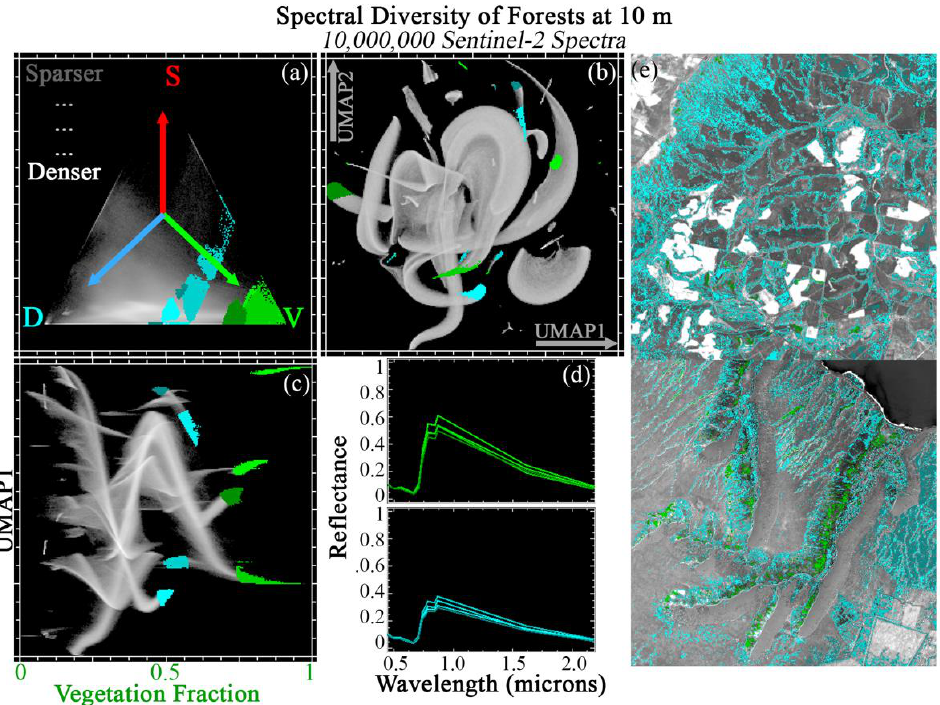
Figure 9. Joint characterization of forests (2). 10 × 1 megapixel Sentinel-2 tile subsets are selected from global forest diversity hotpots and analyzed at full 10 m pixel resolution. These spectra preferentially occupy the V to D apexes of the SVD mixing space ( a ), leaving the S portion of the space relatively sparse. The global 3-endmember linear mixture model fits these spectra better than the agricultural spectra (here, > 99.9% of spectra with <5% RMSE). UMAP ( b ) captures both subtle mixing continua and discrete clusters, but does not offer physical interpretability. Joint characterization ( c ) uses the physical meaning of the Vegetation mixture fraction to contextualize the subtle statistical relationships captured by UMAP. Example regions of interest are identified from the joint space and projected onto the ternary mixing and UMAP spaces. Mean spectra for each region ( d ) illustrate similarities and differences among statistically distinct clusters. Clusters identified by joint characterization also frequently show geographic coherence ( e ).